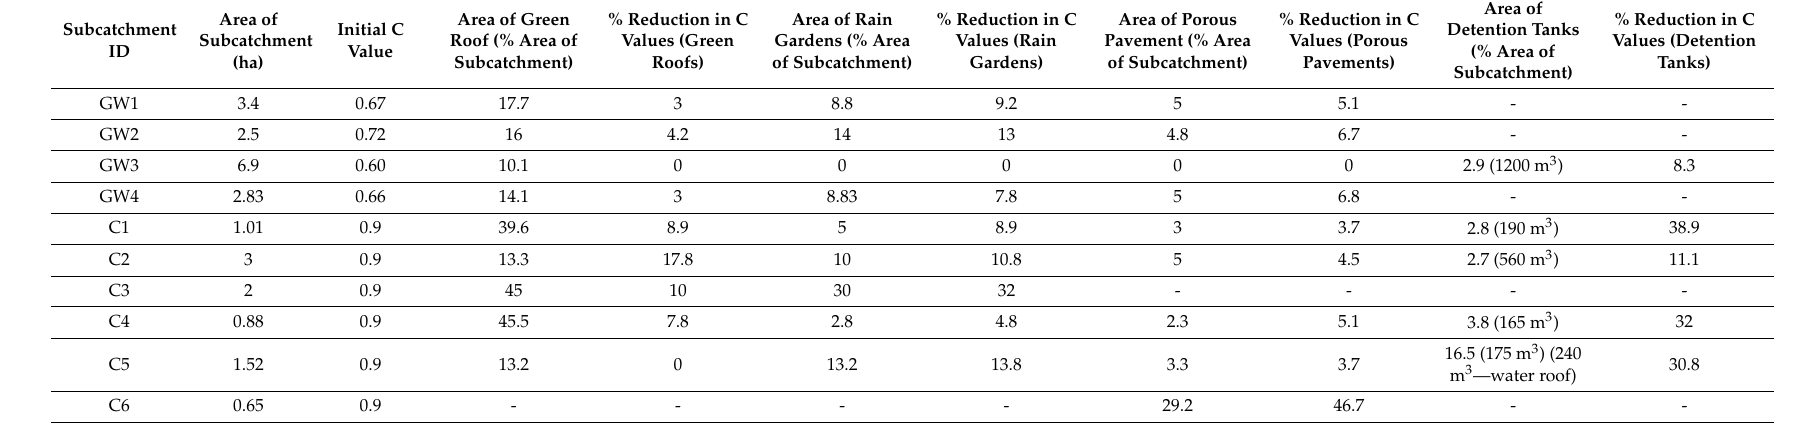
Table 3. Effectiveness of ABC Waters features and detention facilities in reducing C values in Green Walk District and Tengah